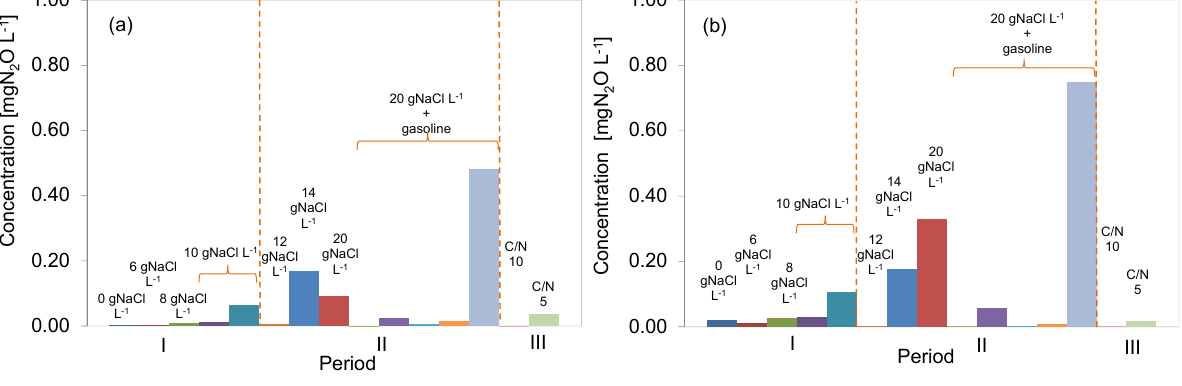
Figure 5. N 2 O concentration in the off-gas of the aerobic ( a ) and anoxic tanks ( b ) for each experimental period. Phase (I) Filling Sequential—Batch Membrane Bioreactor